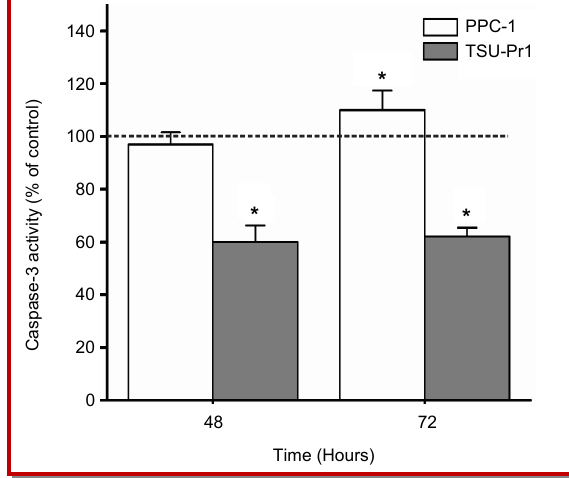
Figure 2: Caspase-3 activity in PPC-1 and TSU-Pr1 cells after axitinib and dasatinib treatment (20 mM) for 48 and 72 hours. Results are expressed as % of control (dashed line)